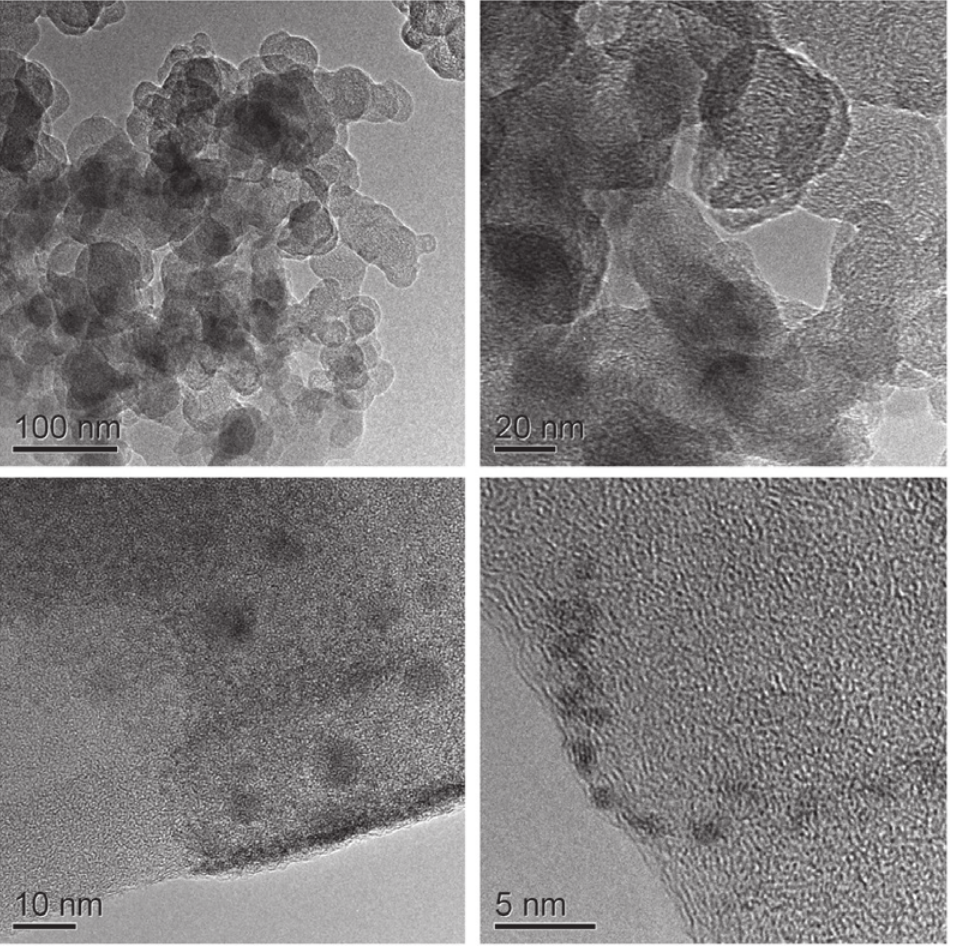
films with different 3